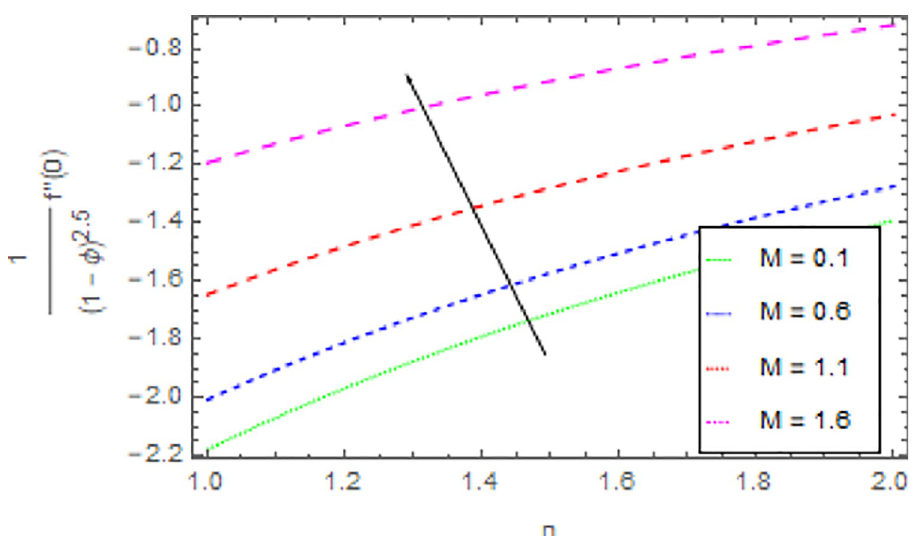
Fig 16. Deviation in skin friction coefficient of velocity ( x − direction) against M and n when Pr = 1000, m = 0.10, δ = 0.40, β = 1.00, Nr = 0.20 and ϕ = 0.01 to ϕ = 0.04.